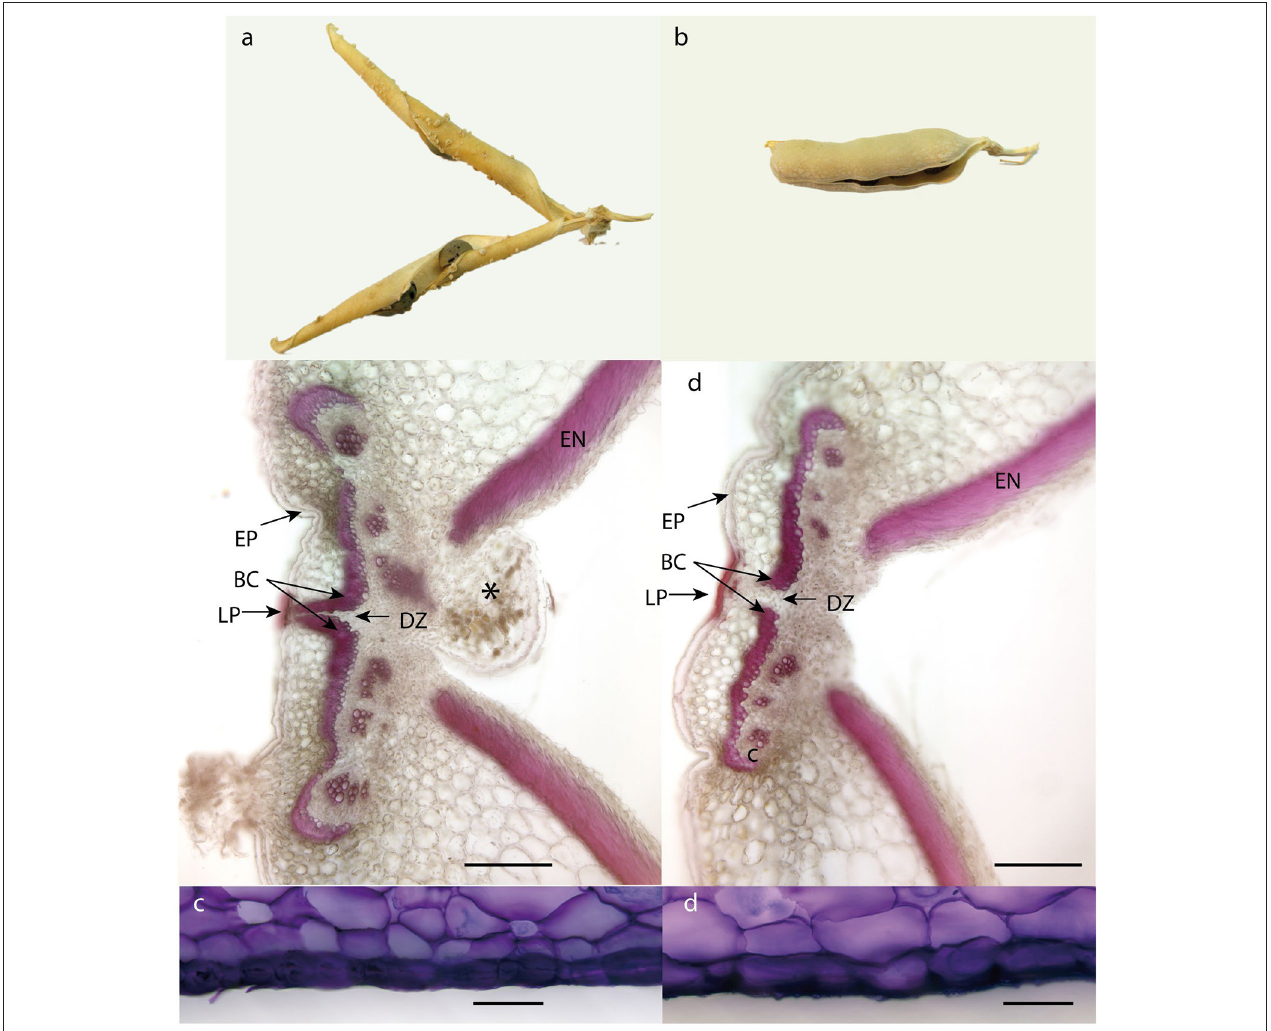
FIGURE 11 | Dorsal side of pea dehiscent and indehiscent pod. (a) Mature pod of dehiscent line (JI 64). (b) Mature pod of indehiscent line (JI 92). (c,d) Sections of dorsal side of dehiscent and indehiscent pea pod stained with fluoroglucinol: *, funikulus; BC, bundle cap; DZ, dehiscence zone; EN, endocarp, including